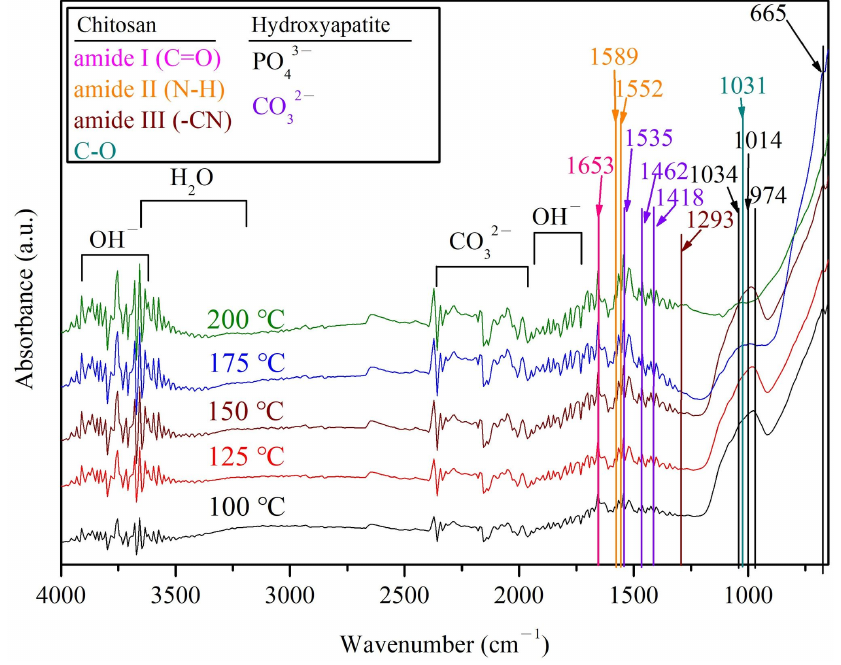
Figure 8. FTIR spectra of HA/CS composite coatings on Ti–25Nb–8Sn alloy after alkali treatment and hydrothermal reaction at various temperatures after soaking in SBF for 7 days.